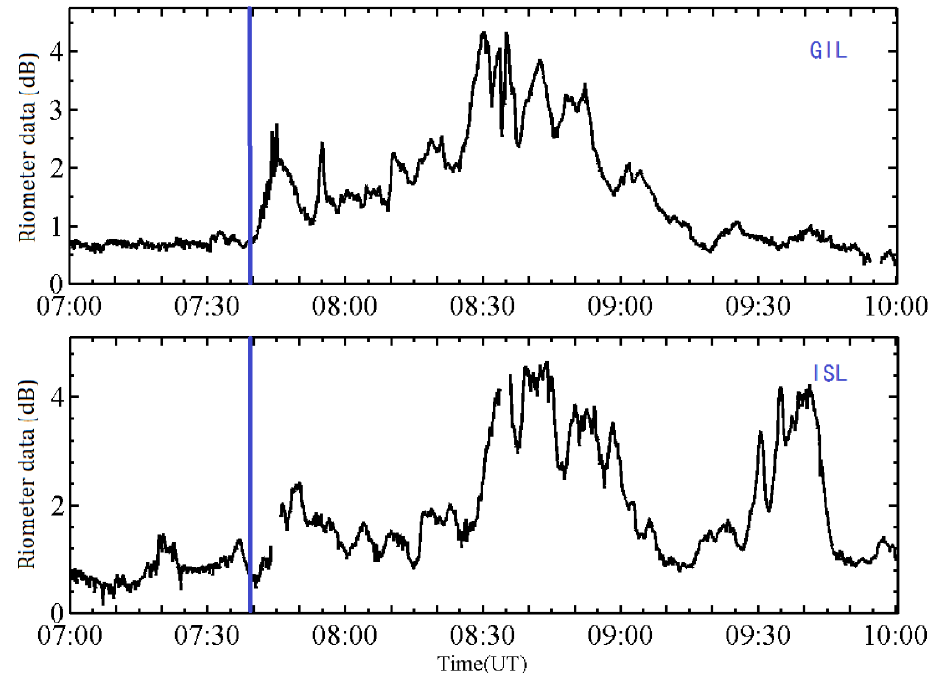
Figure 5. The GIL and ISL riometers absorption, with the start of the absorption event denoted by the vertical line. The absorption data increased sharply at 07:39 UT (noted by vertical line). The VLF radio wave paths (indicated by the red curve in Figure 1, L < 3.6) in the paper were in the equatorward zone of the IB during the interval from 08:01 UT to 08:29 UT, therefore, the propagation of those VLF radio waves could not be interfered with by elec- tron precipitation within the isotropic zone in this interval. All three paths (NLK–Boston, NAA–Cheyenne, NAA–LAS) pass through the region of energetic electron precipitation within the anisotropic zone ( L = 3.71~2.92) detected by the NOAA 16 satellite. The ampli- tude of the subionospheric VLF waves from 05:00 UT to 10:00 UT is shown in Figure 6. The amplitude of VLF radio waves received at Boston and Cheyenne showed obvious variations from 07:50 UT, while those received at LAS showed obvious variation from 08:00 UT. The amplitudes of VLF radio waves from the NAA-LAS path and NAA-CHE path decreased by 6 dB. On the contrary, as shown in Figure 6, the amplitude of VLF wave from the NLK-Boston path increases by about 6 dB. The amplitude variations of VLF radio waves imply a secondary ionization in the lower ionosphere along the propagating paths from the transmitters to the receivers. With the conjugate observations of the NOAA sat- ellite and the VLF waves propagating through the precipitating electron region as well as the precipitating proton region within the anisotropic zone in the interval from 08:01 UT to 08:29 UT, the variations of VLF waves amplitude may be contributed to precipitating energetic electrons or energetic protons within the anisotropic zone in the interval.